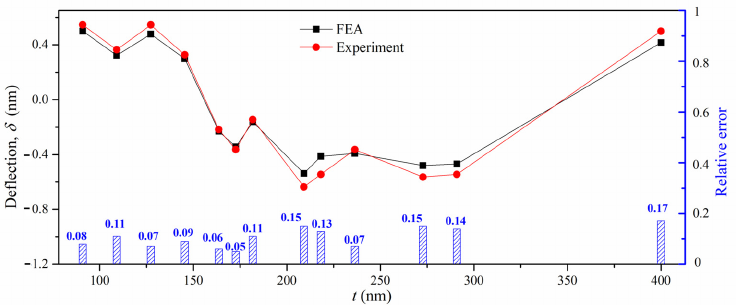
Figure 12. The comparison of the measured deflection and simulated